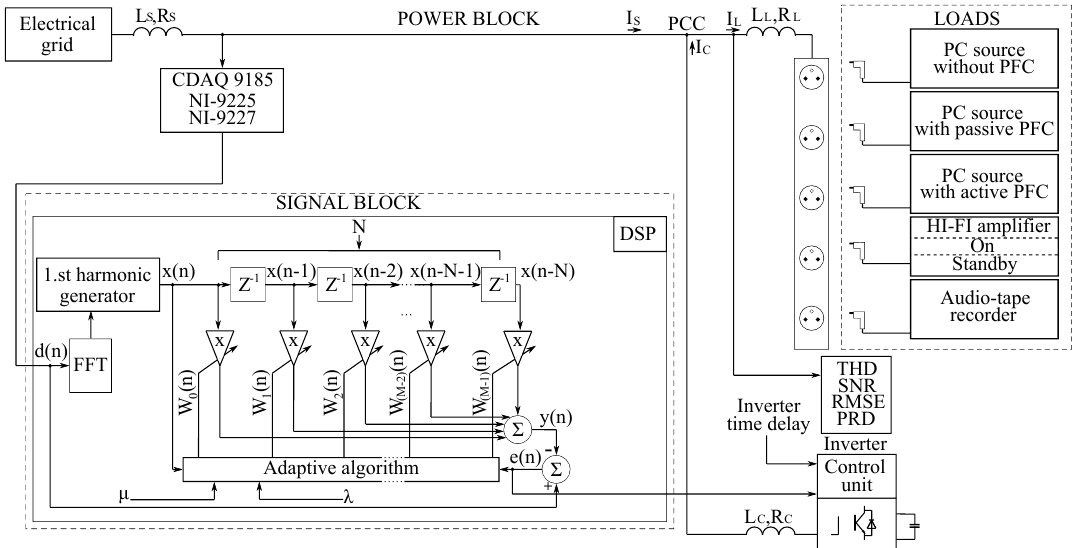
Figure 8. Block diagram of the